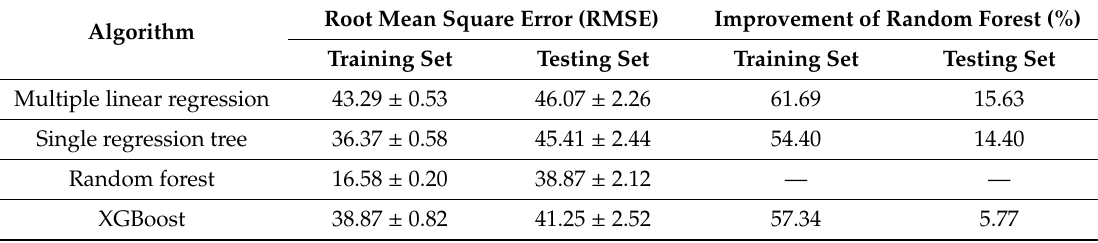
Table 6. Root mean square error (mean ± standard deviation) of annual EUI for training and testing sets of di ff erent models. Performance improvement by comparing random forest model with other models (%) is provided in the last two columns.